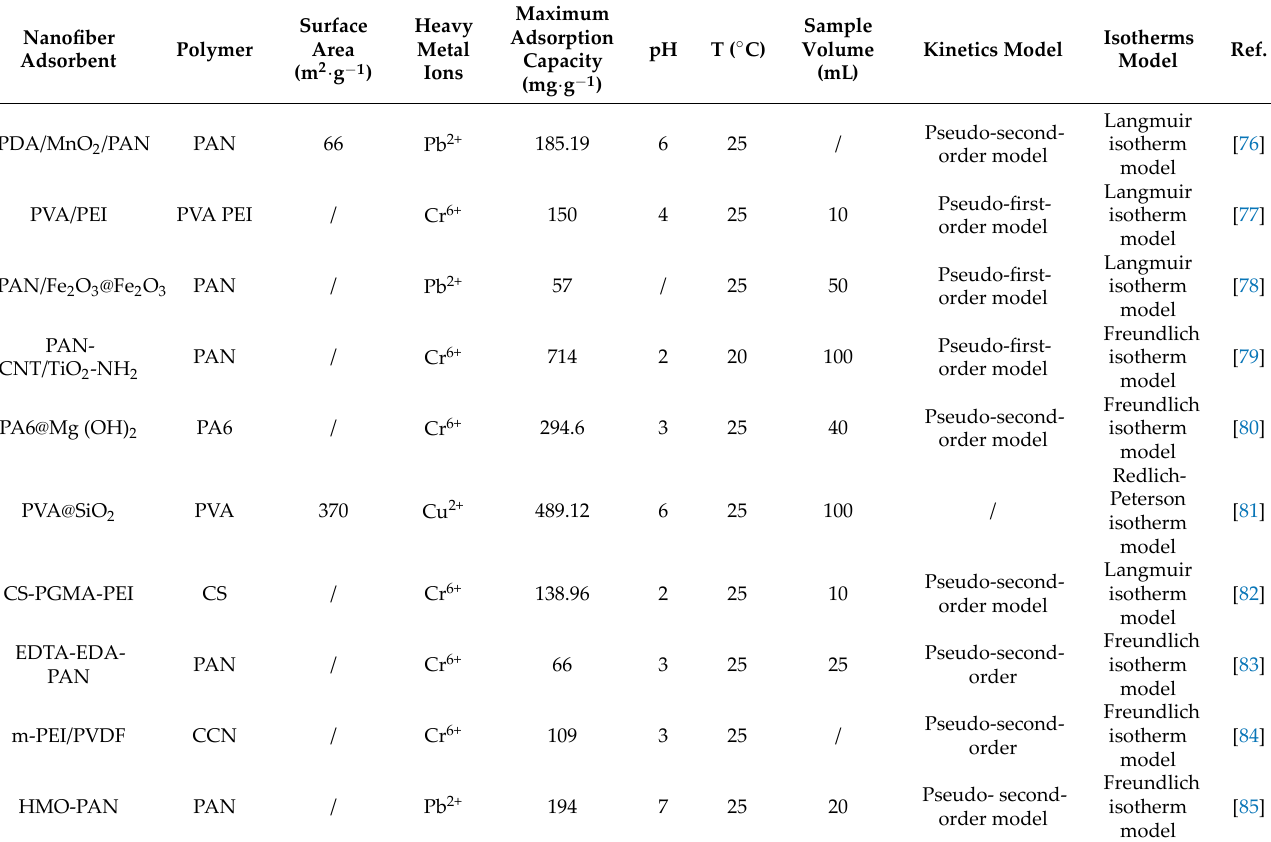
Table 1. The adsorption performance of other nanofiber adsorbents for heavy metal